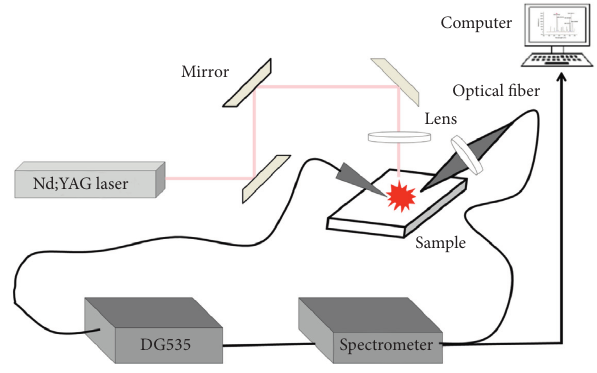
Figure 1: LIBS experimental